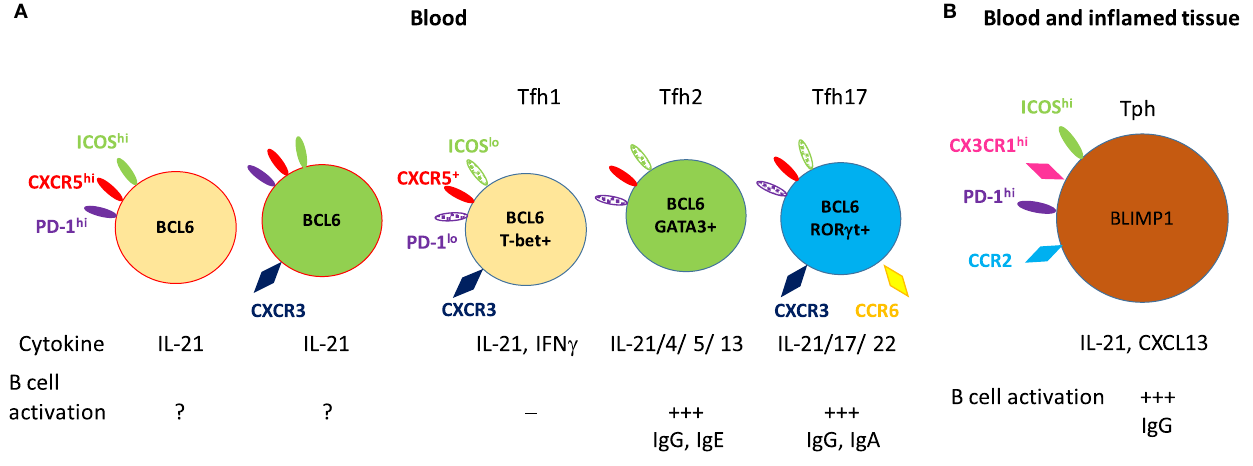
FiGURe 1 | Subsets of circulating memory follicular helper T (Tfh) cells and their B cell activation. (A) The circulating CXCR5 + memory Tfh subsets. The minor CXCR5 + CD4 + T cells (1–5% of CXCR5 + CD4 + CD4 + T cells) express high levels of inducible co-stimulator (ICOS) and programmed cell death protein 1 (PD-1) and consist of CXCR3-positive or CXCR3-negative populations. The majority of CXCR5 + CD4 + T cells are low to negative in expression of ICOS and PD-1. These cells are subgrouped into Tfh1, Tfh2, and Tfh17 based on their chemokine receptor expression. These five subsets of Tfh cells express B cell lymphoma 6 as a master transcriptional regulator, and also express subset-specific transcription factors, effector cytokines, and activate naïve B cells to antibody-secreting cells. (B) CXCR5 − CD4 + T cells [peripheral helper T (Tph)] which express high level of PD-1 exhibit strong B cell activation. These Tph cells developed under inflamed conditions and are found in both inflamed tissue and blood. Solid color indicates high level of expression and patterned color indicates low level of